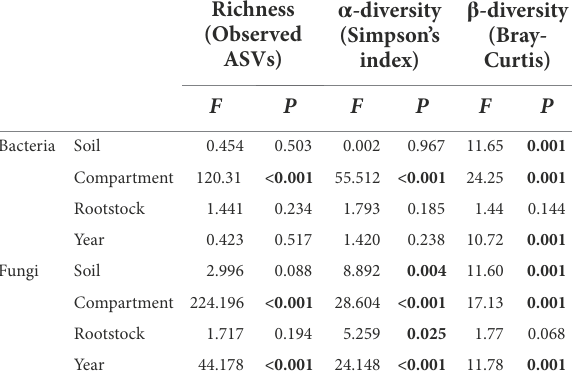
Significances were assessed through a Type II ANOVA for richness and α -diversity while PERMANOVA (permutations = 999) was calculated by terms from “capscale” function using Soil + Compartment + Rootstock + Year model. p -values <0.05 are highlighted in